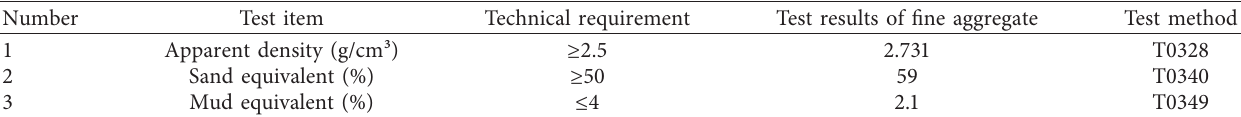
Table 3: Physical and mechanical indices of fine aggregate (0 ∼ 3 mm).